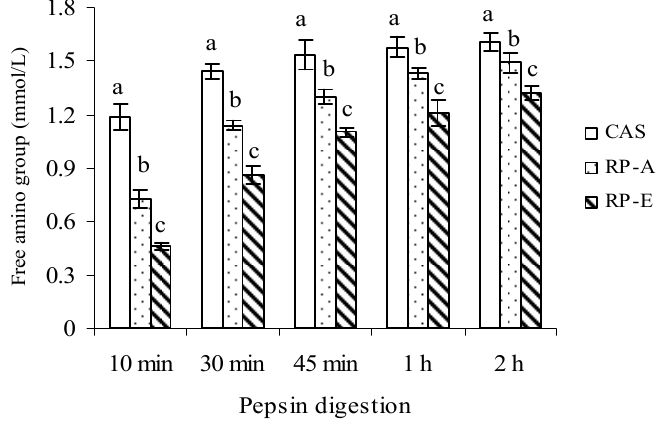
Figure 1. Effects of dietary proteins on free amino groups during pepsin digestion (10 min, 30 min, 45 min, 1 h, 2 h). Values are means ± SEM ( n = 3). Bars for each value with different letters are significantly different ( P < 0.05).